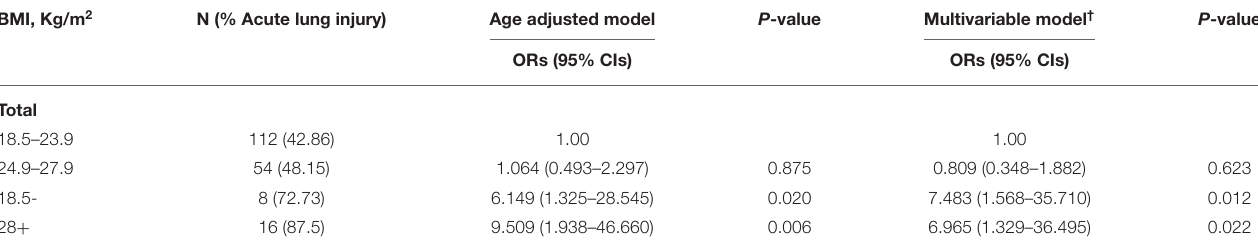
† Adjusted for age, sex, disease history (hypertension, diabetes, cardiovascular disease and cancer), as